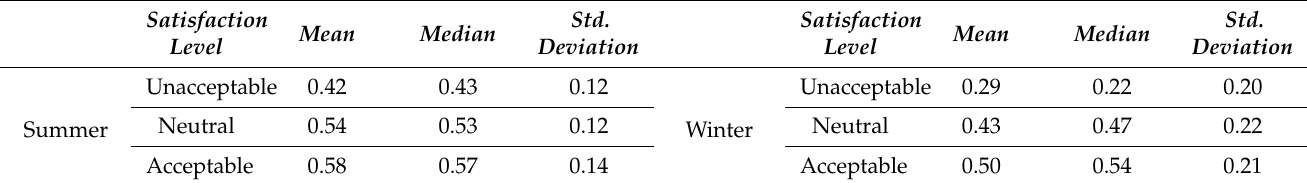
Table 6. Satisfaction level of DTR in summer and winter.